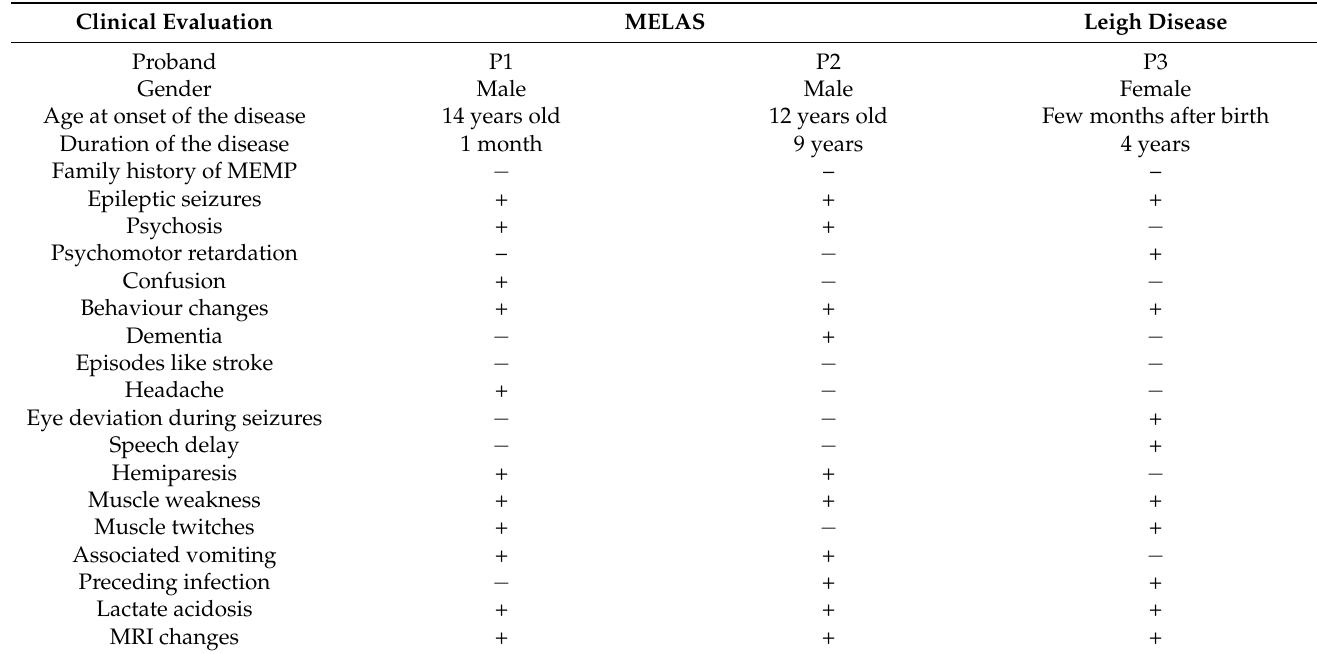
Table 3. Clinical evaluation for MELAS and Leigh